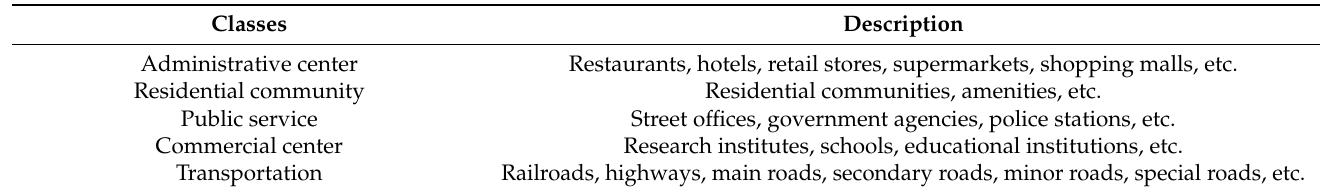
Table 6. POI reclassification